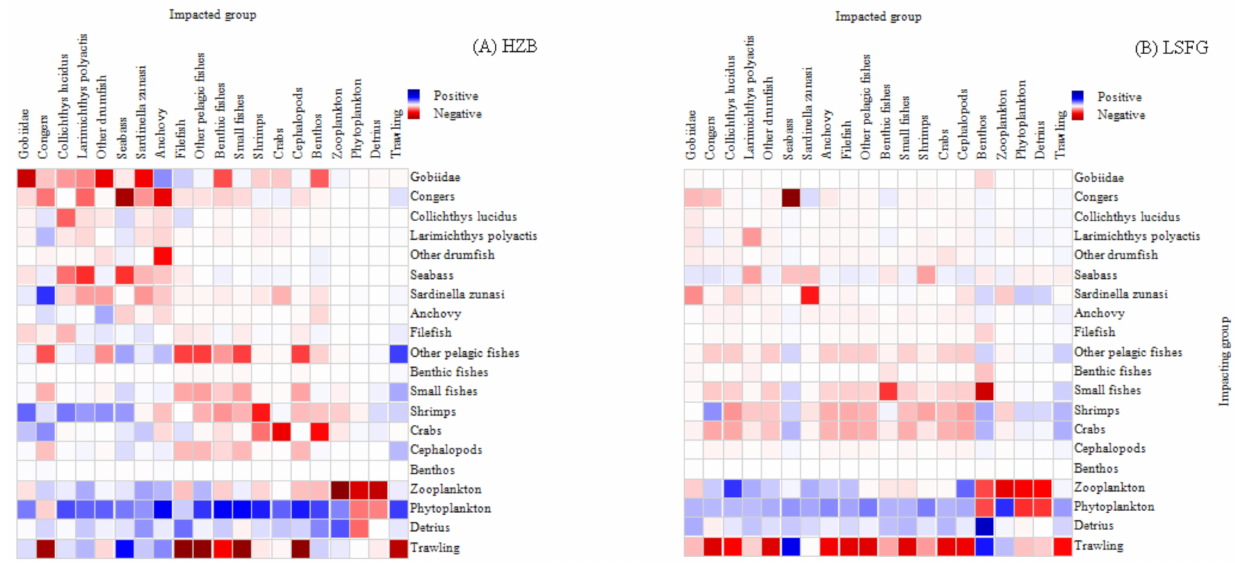
Figure 5. MTI analysis in two models. ( A ) Haizhou bay; ( B ) Lvsi fishing